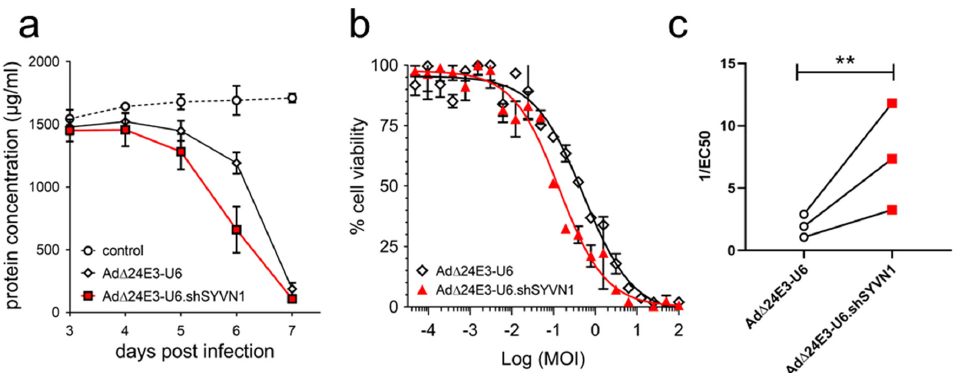
Figure 5. Oncolytic adenovirus expressing shRNA against SYVN1 exhibits enhanced oncolysis in A549 cells. A549 cells were infected with Ad Δ 24E3-U6.shSYVN1 or Ad Δ 24E3-U6 at 10 IU/cell ( a ) or in a 2-fold dilution titration over the range of 4.8 × 10 -4 to 100 IU/cell ( b , c ). Cell viability was determined by BCA protein assay on days 3 to 7 ( a ) or on day 7 ( b , c ) after infection. Both types of experiments were done three times in triplicate. Data in a are the mean results of three independent experiments ± SD; ( b ) shows representative sigmoidal dose-response curves from a single experiment in triplicate. [The two other experiments are shown in Supplementary Figure 2]; ( c ) shows the paired comparison of the oncolytic adenovirus cytotoxicity, i.e., 1/EC 50 calculated from the dose-response curve of the two viruses in the three independent experiments. **, p < 0.01 (two-tailed paired t -test). Next, we investigated oncolytic activities of Ad Δ 24E3-U6 and Ad Δ 24E3- U6.shSYVN1 in intact tumors in vivo . To this end, A549 subcutaneous xenograft tumors were established on the flanks of nude mice. Virus or vehicle were injected intra-tumor- ally, and tumor volumes were monitored. Both viruses effectively inhibited tumor growth compared to vehicle controls (Figure 6a). Tumor volumes of vehicle-treated controls ex- panded 6.2-fold in 55 days, at which point animals from this group had to be sacrificed because their tumor size exceeded 2000 mm 3 . At this time, Ad Δ 24E3-U6- and Ad Δ 24E3- U6.shSYVN1-treated tumors were on average only 1.3- and 1.2-fold larger than at the time of treatment. Although differences between the two viruses were not significant, SYVN1 silencing appeared to elicit a more immediate tumor growth inhibition. Ad Δ 24E3-U6-in- duced tumor regression became apparent approximately 3 weeks after treatment but never reached significance due to a rather high tumor volume variability. In contrast, growth inhibition by Ad Δ 24E3-U6.shSYVN1 was evident already after 9 days and was significant from 2 to 5 weeks after treatment ( p < 0.05, one-way ANOVA).